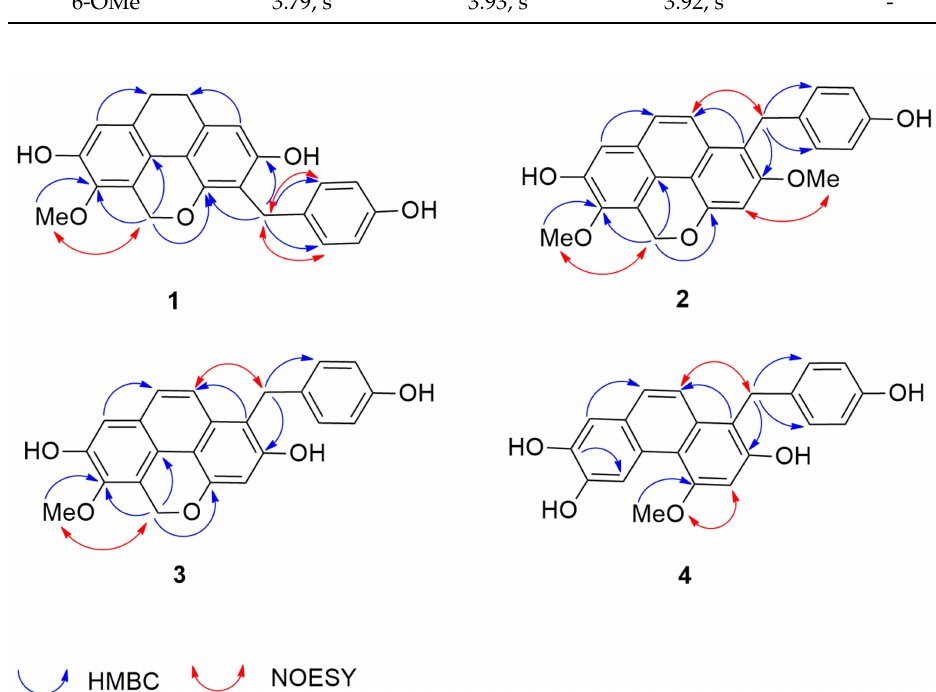
Figure 3. The key HMBC and NOESY correlations of compounds 1 – 4